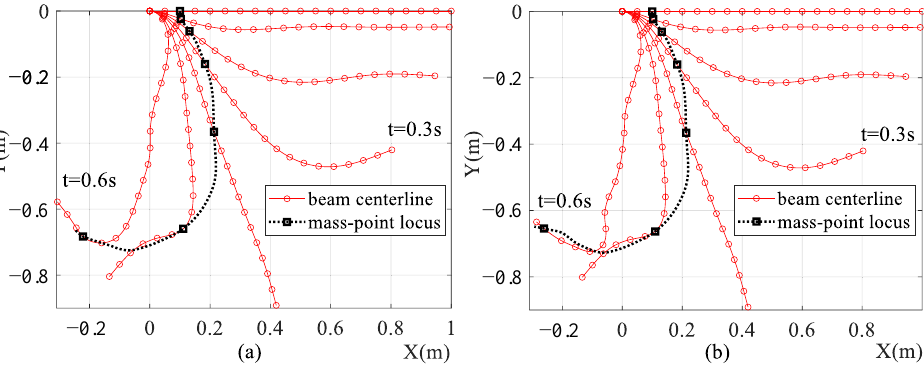
Figure 9. Configurations of ( a ) ALE-RANCF and ( b ) ALE-ANCF models.